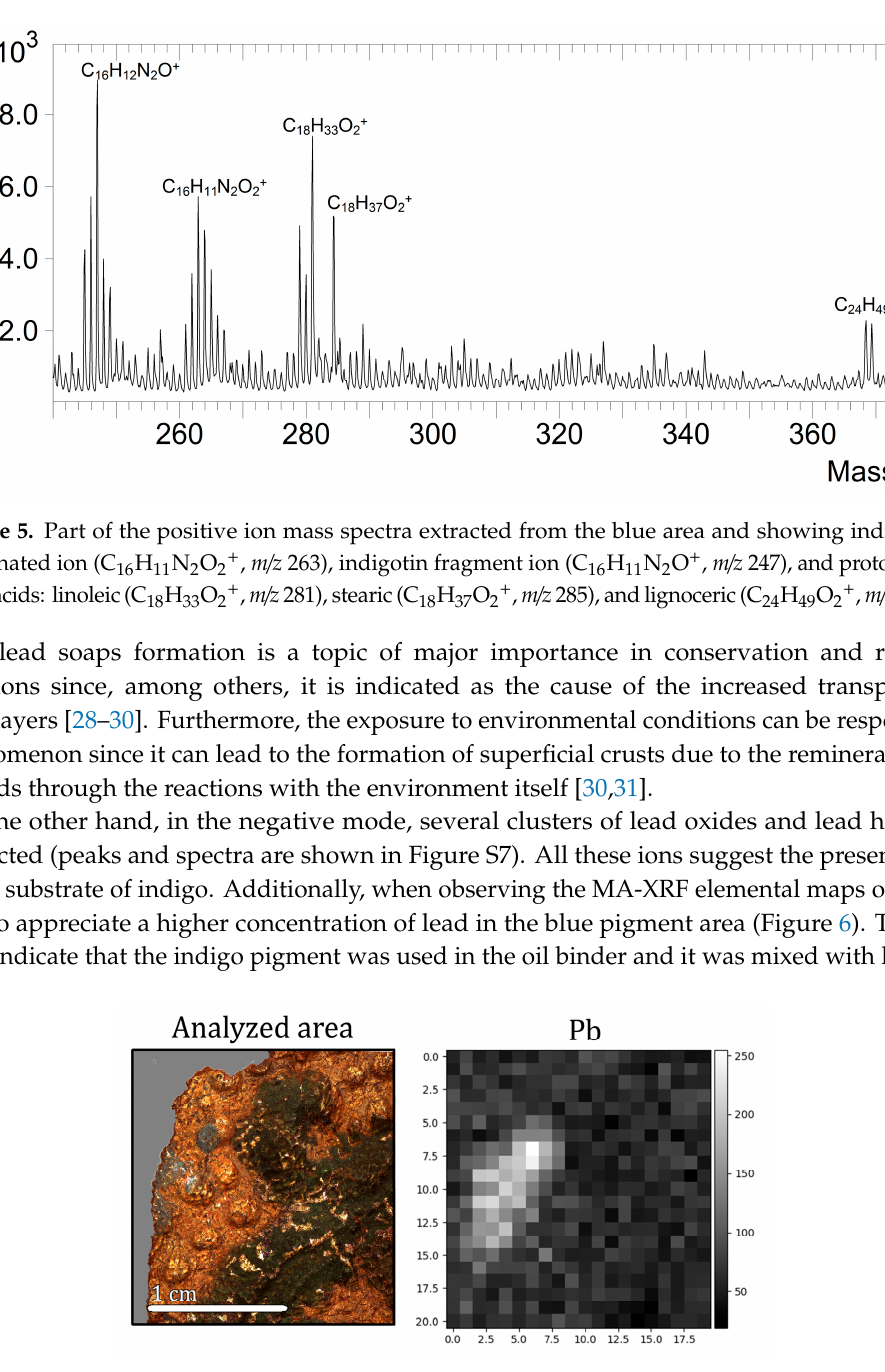
Figure 6. MA-XRF elemental map of Pb from leather sample 2 (zone 2a).